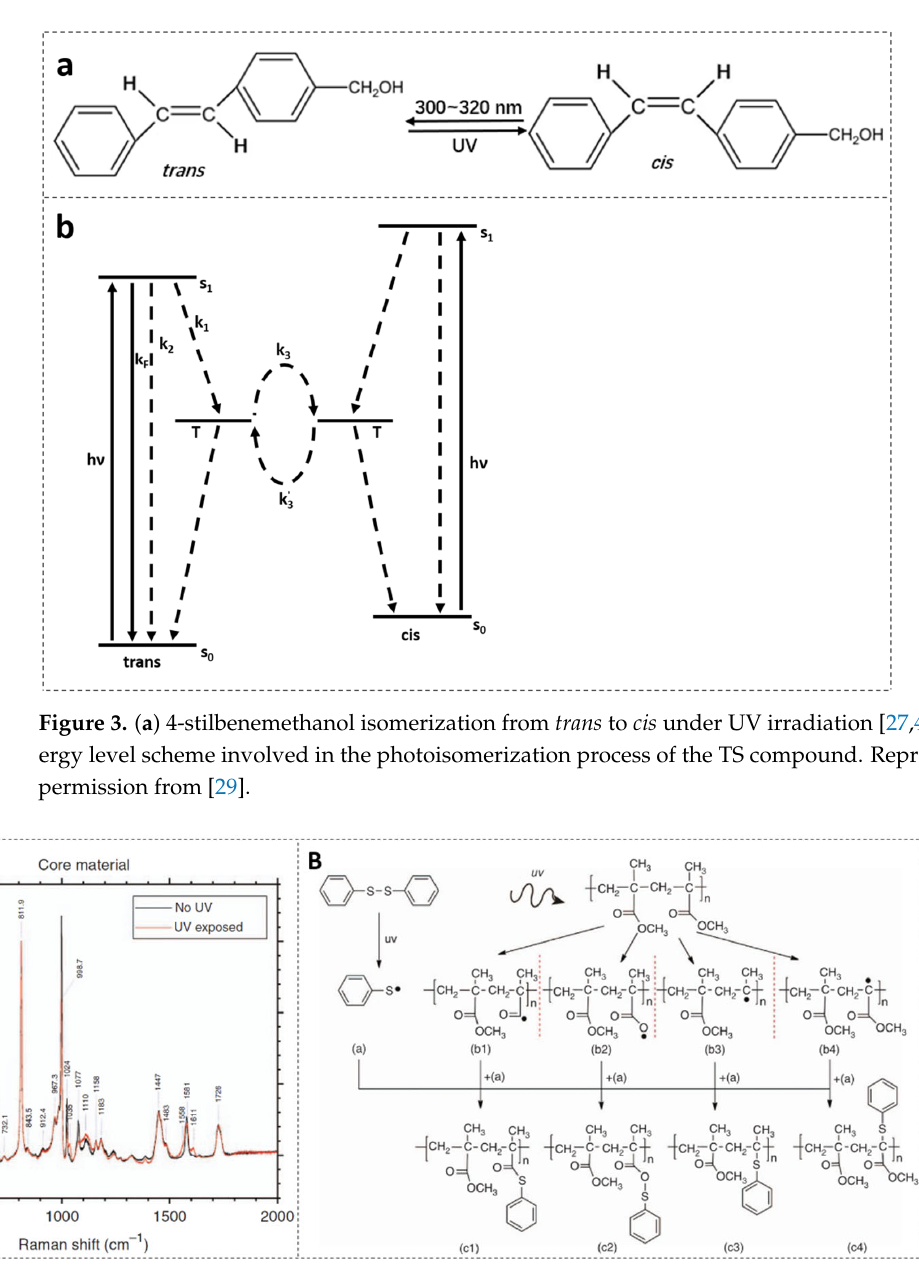
Figure 4. ( A ) Raman spectra before and after UV exposure on the DPDS-doped core material. Reprinted from [4]. ( B ) DPDS is split into two sulphenyl radicals upon UV exposure ( a ), four photodegradation reactions of the PMMA chain are considered, which are the removal of the: OCH 3 group ( b1 ) and CH 3 group ( b2 ) from the side chain, complete side chain ( b3 ) and CH 3 group on the other side of the side chain ( b4 ), followed by the attachment of the sulphenyl radical ( c1 – c4 ), respectively. Reprinted from